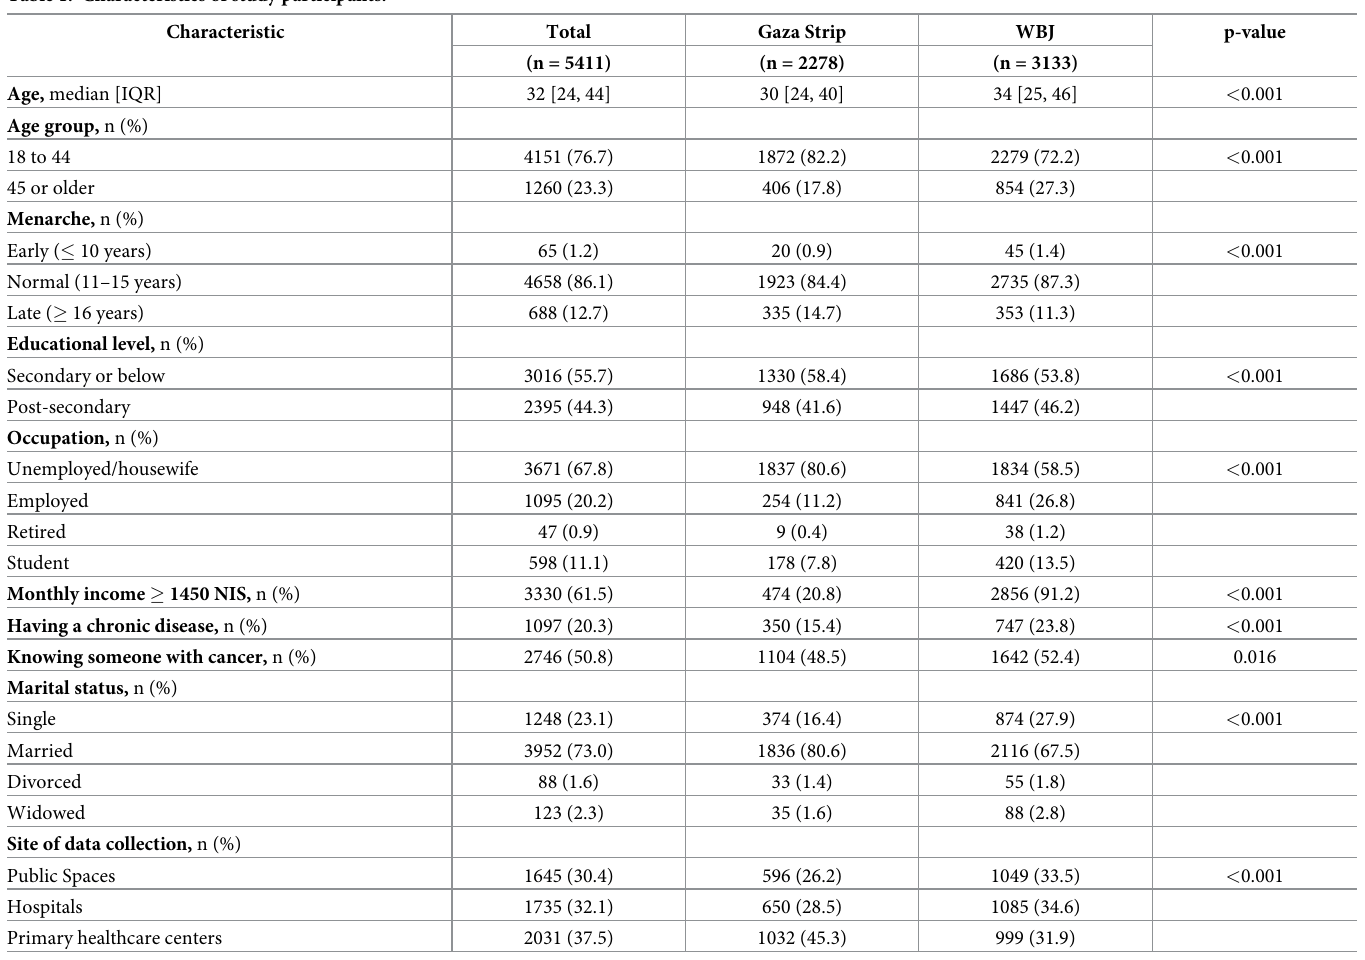
Table 1. Characteristics of study